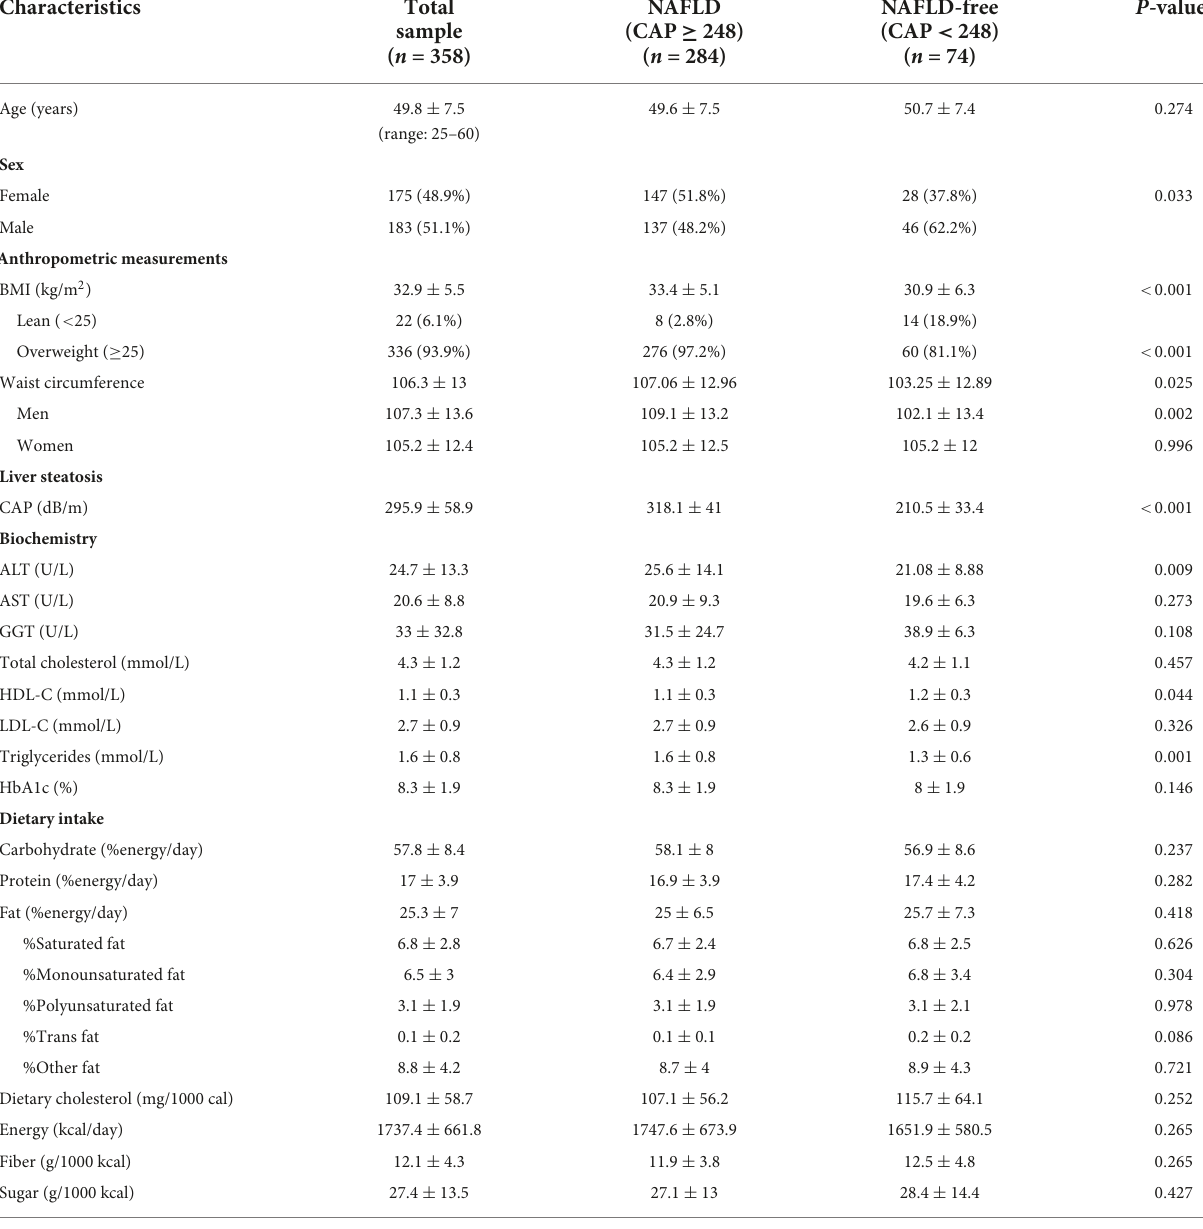
TABLE 1 Baseline characteristics of the study sample stratified by the presence of non-alcoholic fatty liver disease (NAFLD), n = 358.